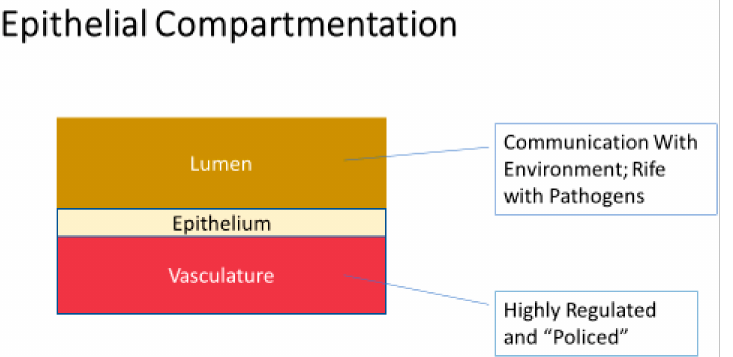
Figure 1. A very basic view of epithelial barrier function—separation of a multitude of different luminal compartments from the vasculature. Communication of these luminal compartments in many cases with the outside environment makes them rife with allergens and pathogens. The immune system, being situated primarily in the vascular compartment, places an enormous premium on barrier integrity segregating the immune system from its activators in these luminal compartments. Failure to separate can then lead to severe and/or chronic